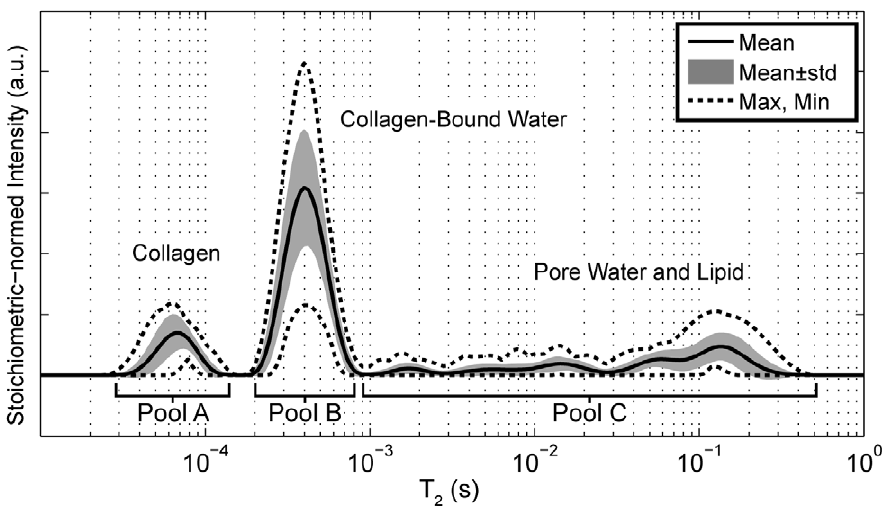
Figure 1. Summary of T 2 spectra measured from 40 human cortical bone samples. All spectra exhibited a short-T 2 component (T 2 < 60 m s), derived primarily from collagen protons, an intermediate T 2 components (T 2 < 400 m s), derived primarily from collagen-bound water protons, and a broad distribution of long-T 2 components (1 ms , T 2 , 1 s), derived from a combination of pore water and lipid protons.